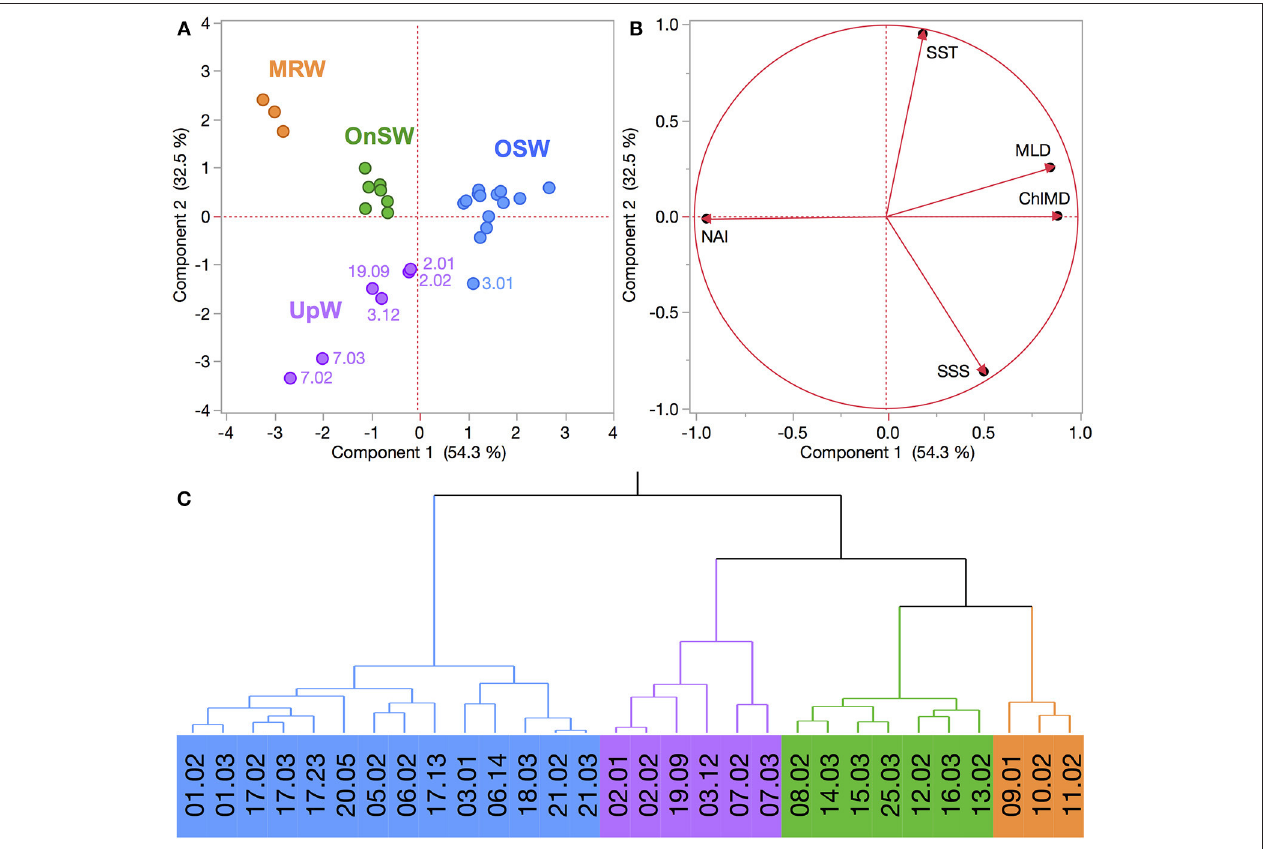
FIGURE 5 | (A,B) PCA of FK160603 CTD casts from the SCS based on the habitat-type defining variables. See Figure 2 for explanation of plots. (C) Wards-mean hierarchical cluster analysis based on the habitat-defining variables. Habitat types are identified by color: Mekong River water (MRW), on-shelf water (OnSW), upwelled water (UpW), and oceanic seawater